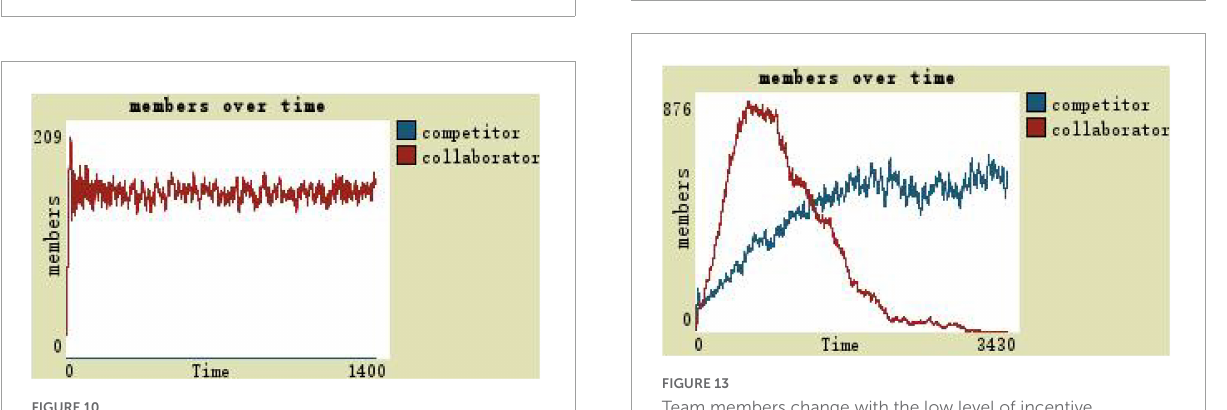
FIGURE10 Members change in high-trust team with the participatory leadership.